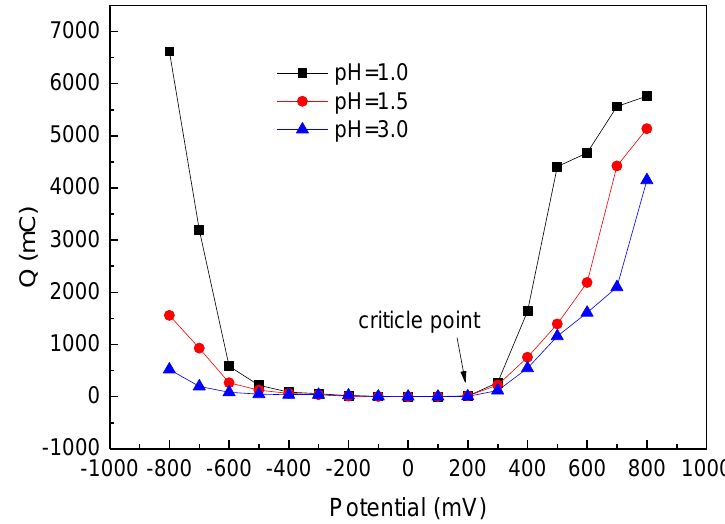
Figure 2. Relationship between total charge and applied potential at pHs of 1.0, 1.5, and 3.0.